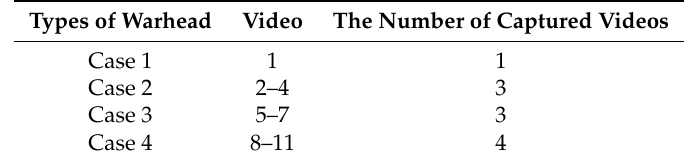
Table 2. The number of test videos from four different types of warhead.